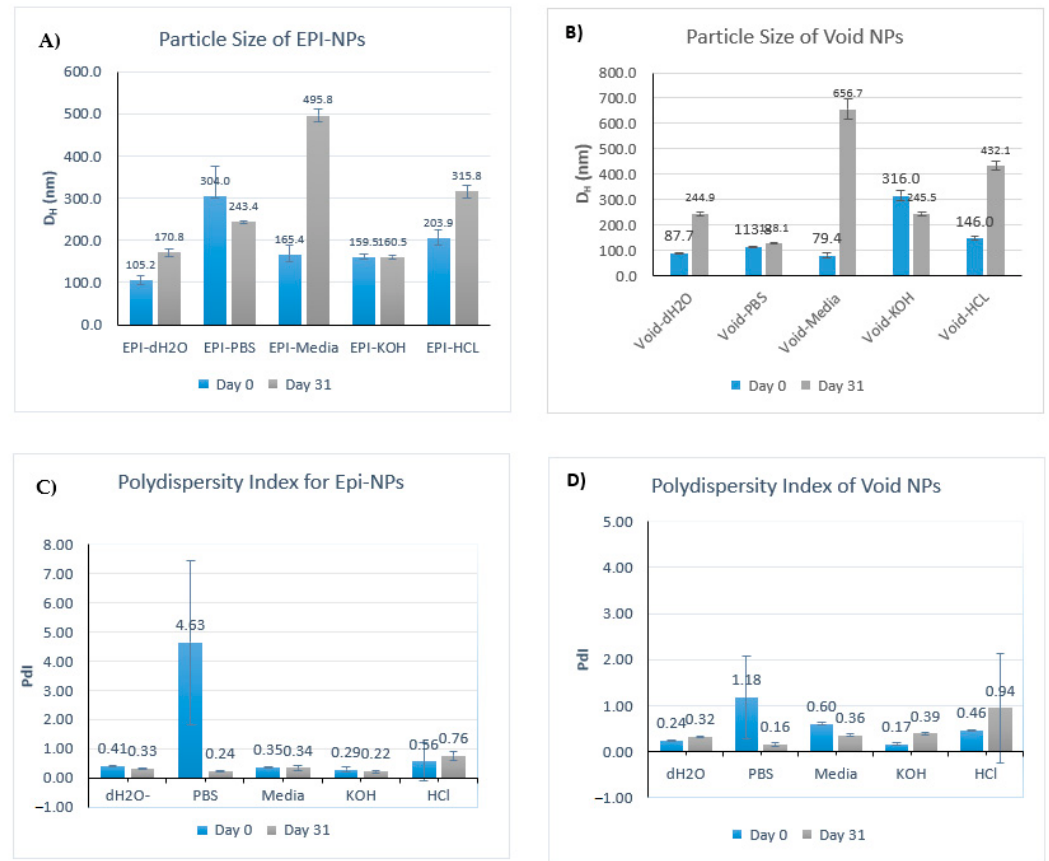
Figure 5. ( A ) Mean particle diameter at day 0 and day 31 for epiribucin-loaded NPs, ( B ) mean particle diameter at day 0 and day 31 for void NPs, ( C ) mean polydispersity index (PdI) at day 0 and day 31 for epiribucin-loaded NPs and ( D ) mean polydispersity index (PdI) at day 0 and day 31 void NPs. The data represent the mean average of the five instrument runs for each sample ±SD. Table 3. Mean particle size at day 0 and day 31 for EPI-NPs and void NPs. The data represent the mean average of the five instrument runs for each sample ±SD.